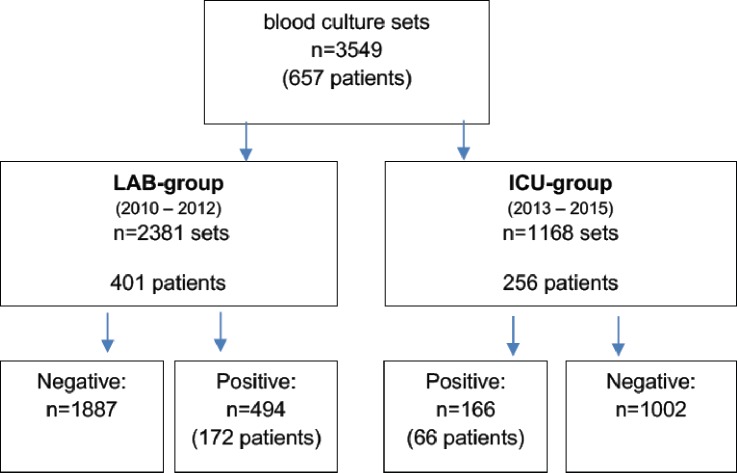
Flow chart of blood culture sets included.Blood cultures (n) were either incubated at the remote microbiology laboratory (LAB group) or incubated on-site at the intensive care unit (ICU group).